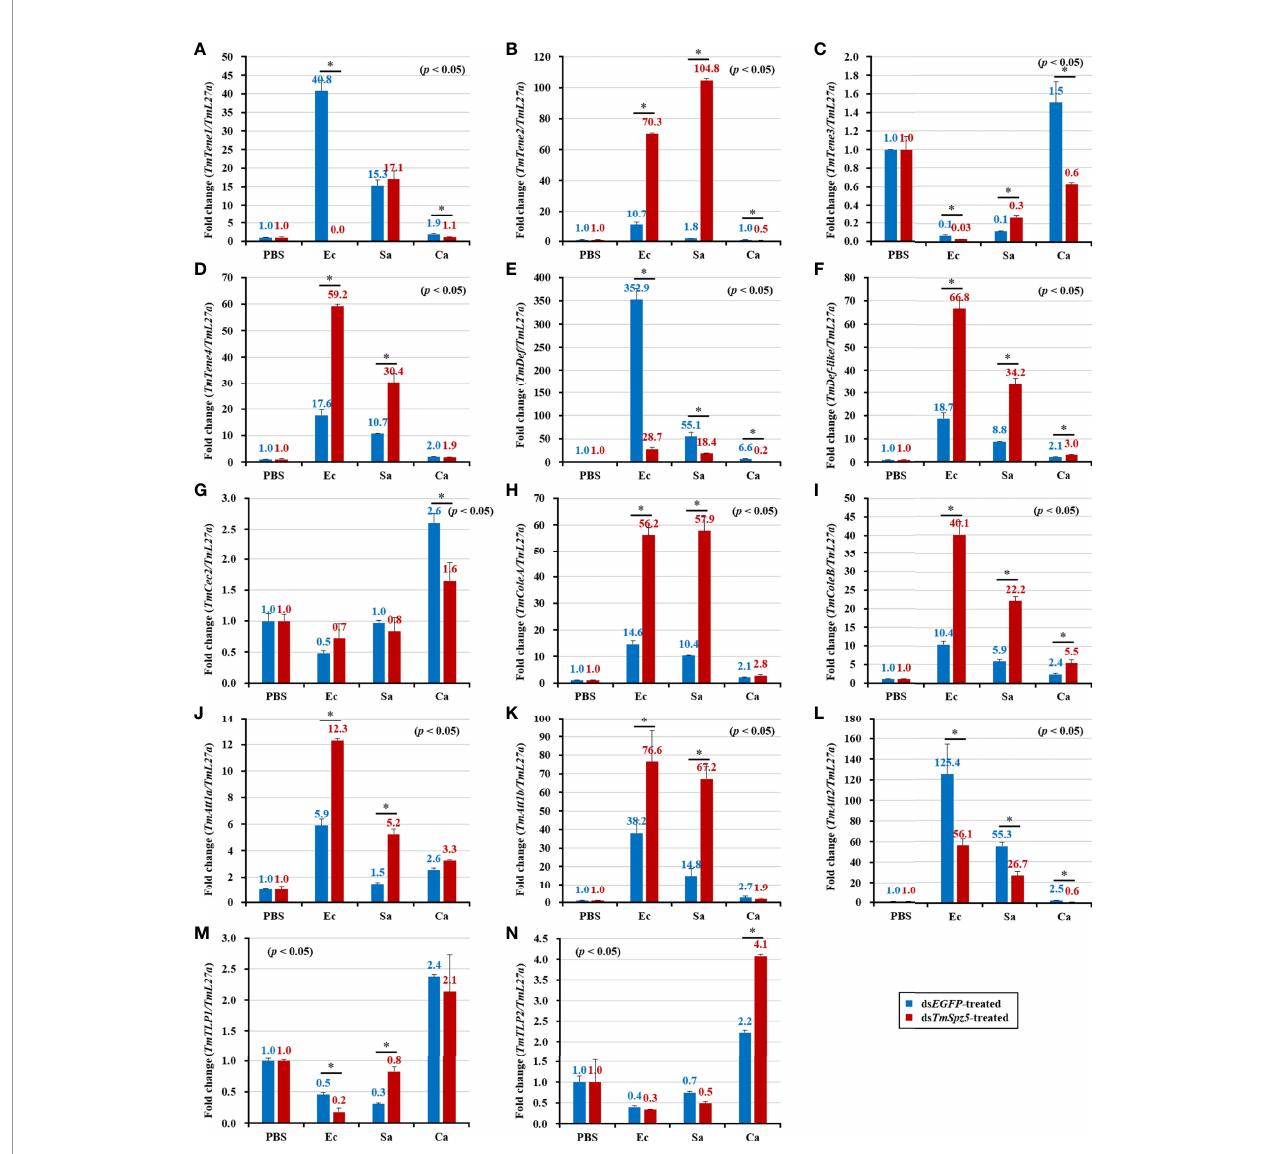
FIGURE 8 | The mRNA expression levels of 14 antimicrobial peptide (AMP) genes after TmSpz5 gene silencing in the hemocytes of T. molitor . Four days after TmSpz5 dsRNA treatment, E. coli (Ec), S. aureus (Sa), and C. albicans (Ca) and PBS as a control were injected. At 24 h after injecting the microbes, the expression levels of TmTene1 (A) , TmTene2 (B) , TmTene3 (C) , TmTene4 (D) , TmDef (E) , TmDef-like (F) , TmCec2 (G) , TmColeA (H) , TmColeB (I) , TmAtt1a (J) , TmAtt1b (K) , TmAtt2 (L) , TmTLP1 (M) , and TmTLP2 (N) were evaluated by qRT-PCR. ds EGFP was injected as a negative control, and TmL27a expression was measured as an internal control. All experiments were performed in triplicate. Asterisks indicate signi fi cant differences between ds TmSpz5- and ds EGFP -treated groups when compared using Student ’ s t -test ( p <